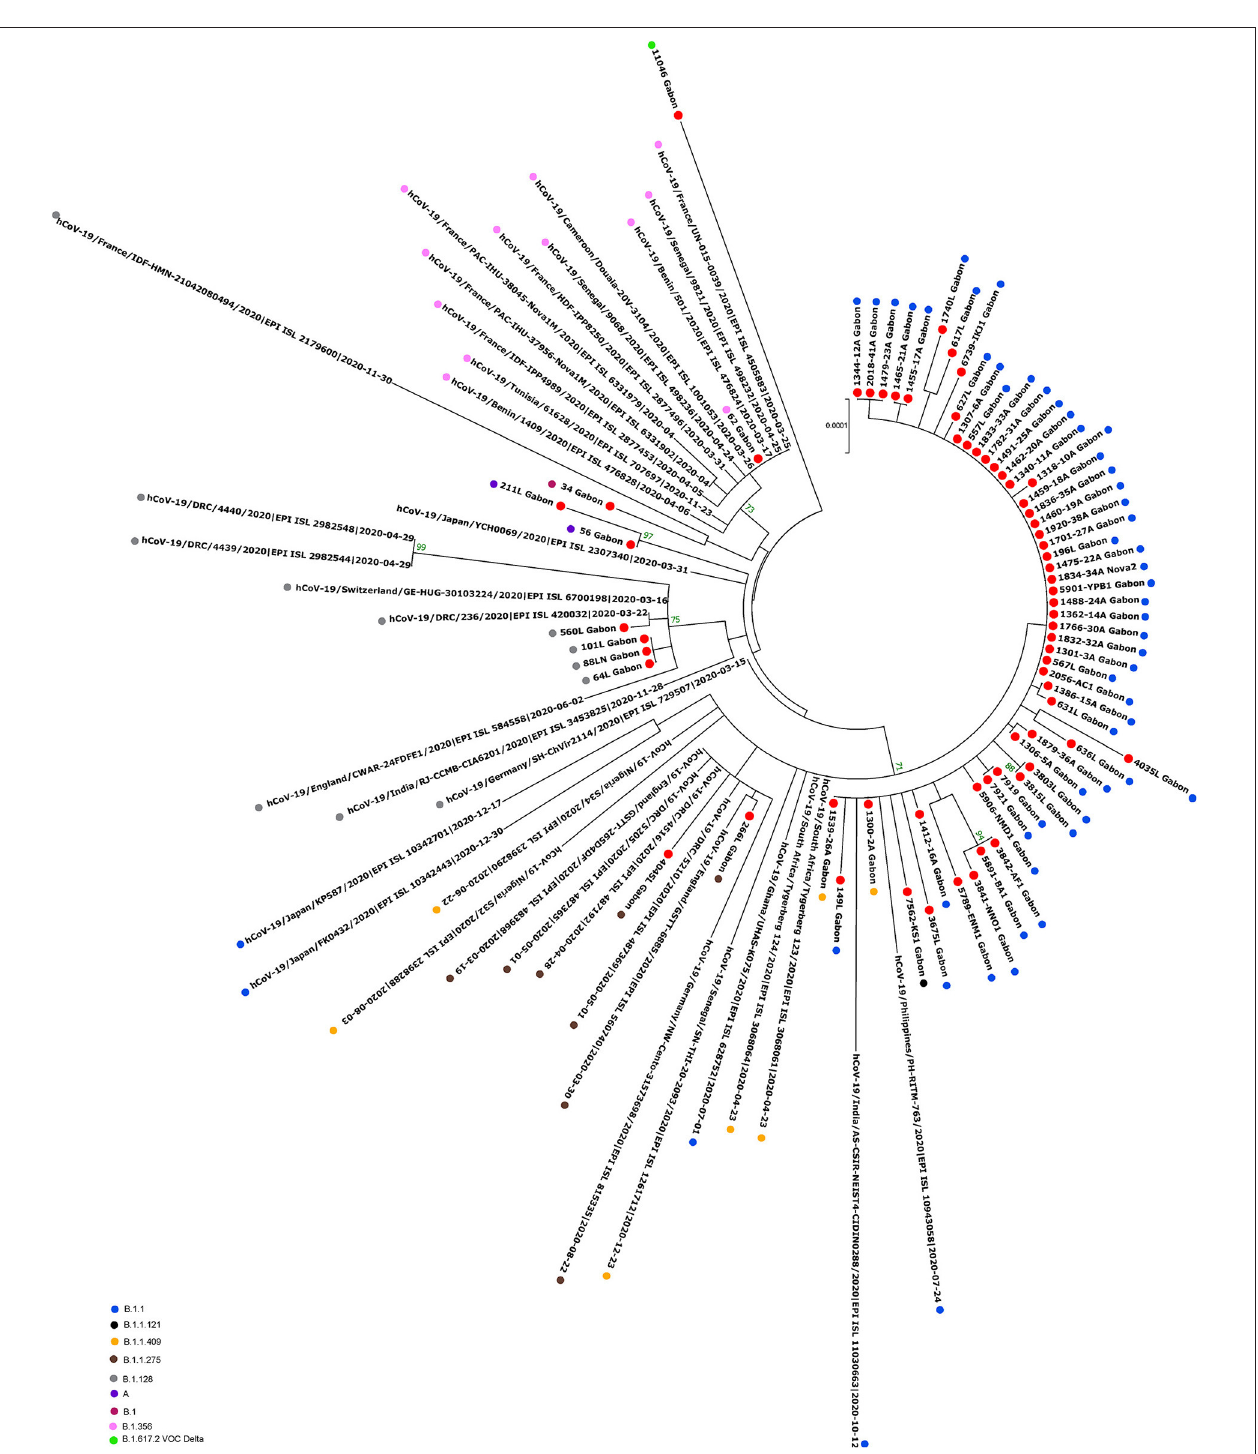
FIGURE 6 | Molecular Phylogenetic analysis by Maximum Likelihood method using 65 sequences from strains circulating during the first wave and the first inter-wave in Gabon and 36 SARS-CoV-2 sequences available in GISAID. The evolutionary history was inferred by using the Maximum Likelihood method based on the Jukes-Cantor model. The tree with the highest log likelihood ( − 41732.01) is shown. Initial tree(s) for the heuristic search were obtained automatically by applying Neighbor-Join and BioNJ algorithms to a matrix of pairwise distances estimated using the Maximum Composite Likelihood (MCL) approach, and then selecting the topology with superior log likelihood value. The tree is drawn to scale, with branch lengths measured in the number of substitutions per site. The analysis involved 101 nucleotide sequences. All positions with < 80% site coverage were eliminated. That is, fewer than 20% alignment gaps, missing data, and ambiguous bases were allowed at any position. There were a total of 28295 positions in the final dataset. Evolutionary analyses were conducted in MEGA7. The red circles correspond to the genomes identified in this study.